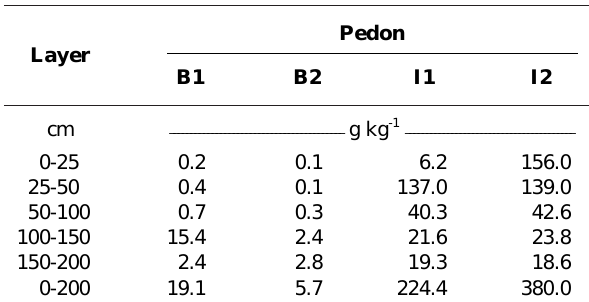
(1) based on bulk densities in Table 1 and Fe Table 2.